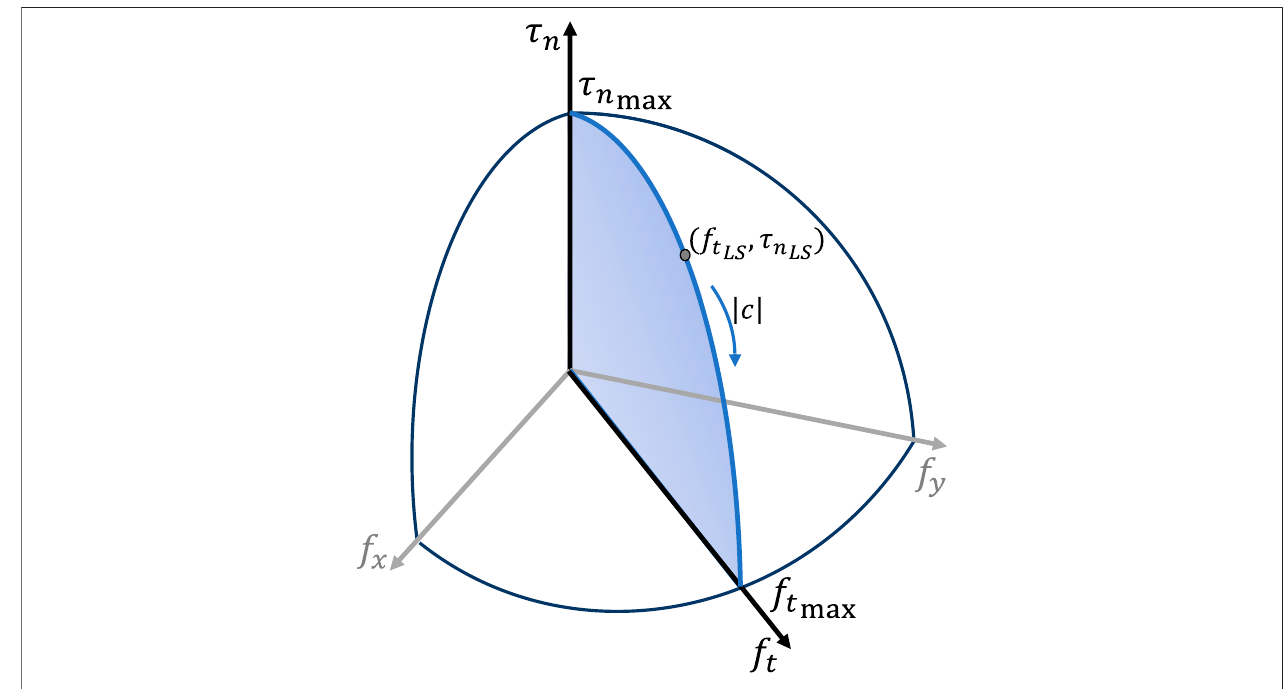
) andtorsional ( τ ) friction; c isthepositionoftheinstantaneousCoR; ( f n max max